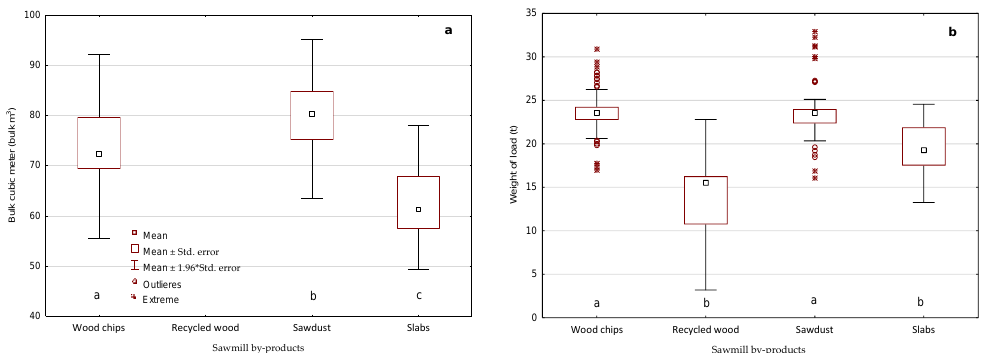
Figure 5. Characteristics of the deliveries depending on the sawmill by-product assortment: ( a ) bulk cubic meter, ( b ) weight of load. Groups with dissimilar lower-case letters (a, b, c, over the x -axis) indicate significant differences, according to a Kruskal – Wallis test or Dunn ’ s multi-sample rank mean comparison test.